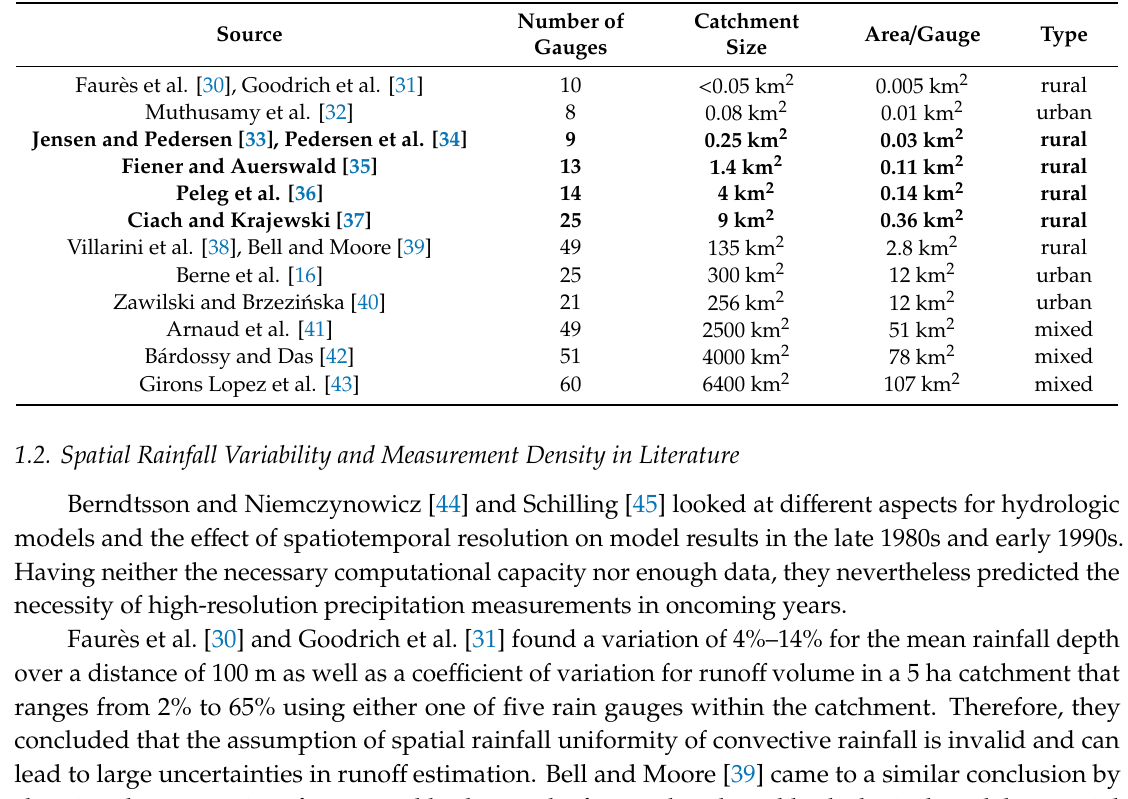
Table 1. Test catchments with high densities of rain gauges investigating spatial rainfall